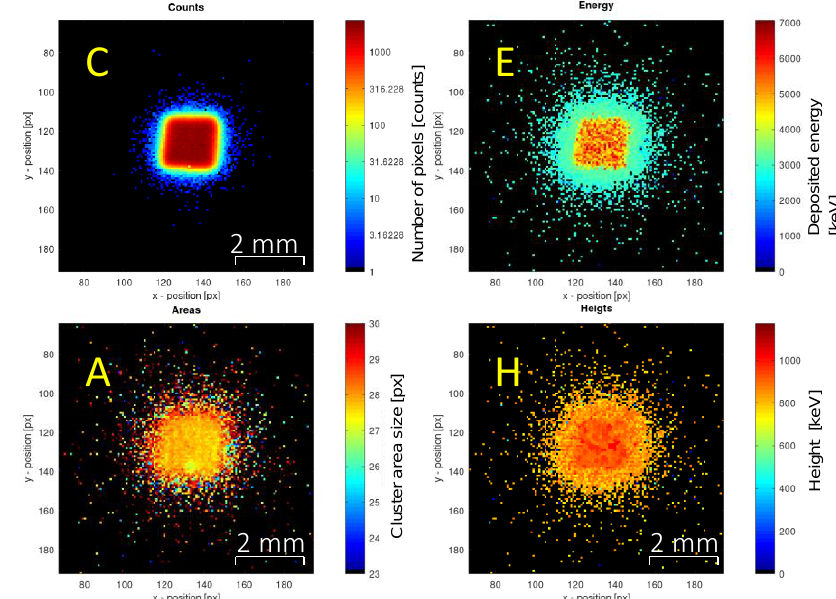
Fig. 4. Proton radiographies of sample C with 2.9 MeV protons measured by a Timepix3 500 µm silicon sensor detector. The images are based on event count (C), deposited energy (E), cluster area sizes (A) and cluster height (H). All images are made from the same set of filtered data (filter used: A > 7 px). The spatial bin is equal to the detector pixel size (55 µm).